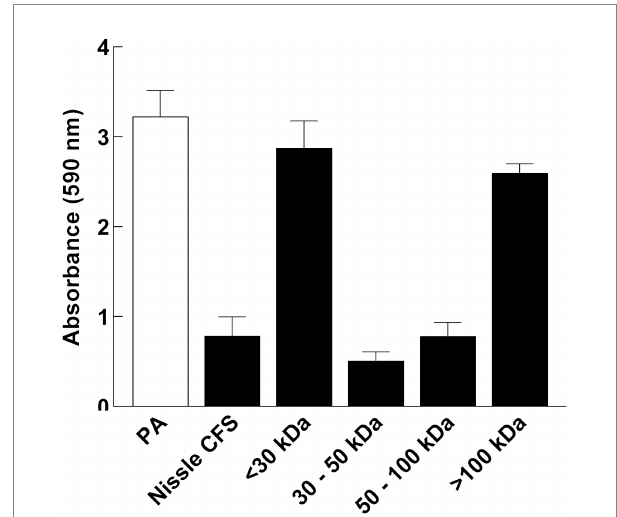
FIGURE 7 P. aeruginosa (PA) biofilm formation was significantly inhibited by 30 and 100 kDa fractions of Nissle cell-free supernatant (CFS), while there was no inhibition observed in fractions lower than 30 kDa and higher than 100 kDa. Aliquots of cell-free supernatant were separated with different molecular sizes and each fraction was tested against biofilm formation by P. aeruginosa . Whole cell-free supernatant was used as a control. Data are mean ± SEM, n = 3.